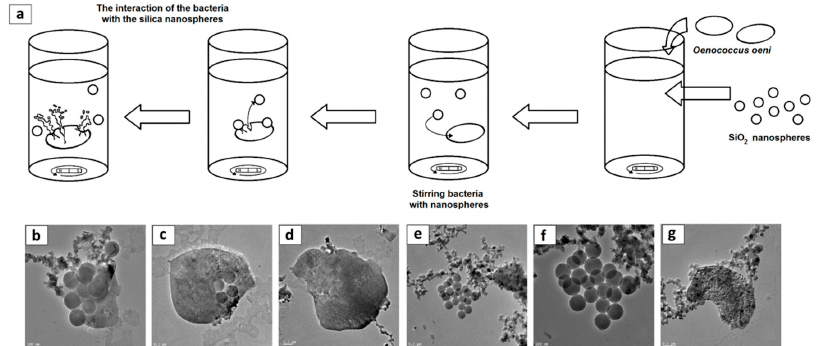
Figure 7. The diagram of O. oeni (DSM7008) cell disruption and release of cytoplasm caused by silica nanospheres ( a ) and TEM images of the “leaking” cells ( b – d ), as well as the absorption of the leakage by silica nanospheres ( e – g ).